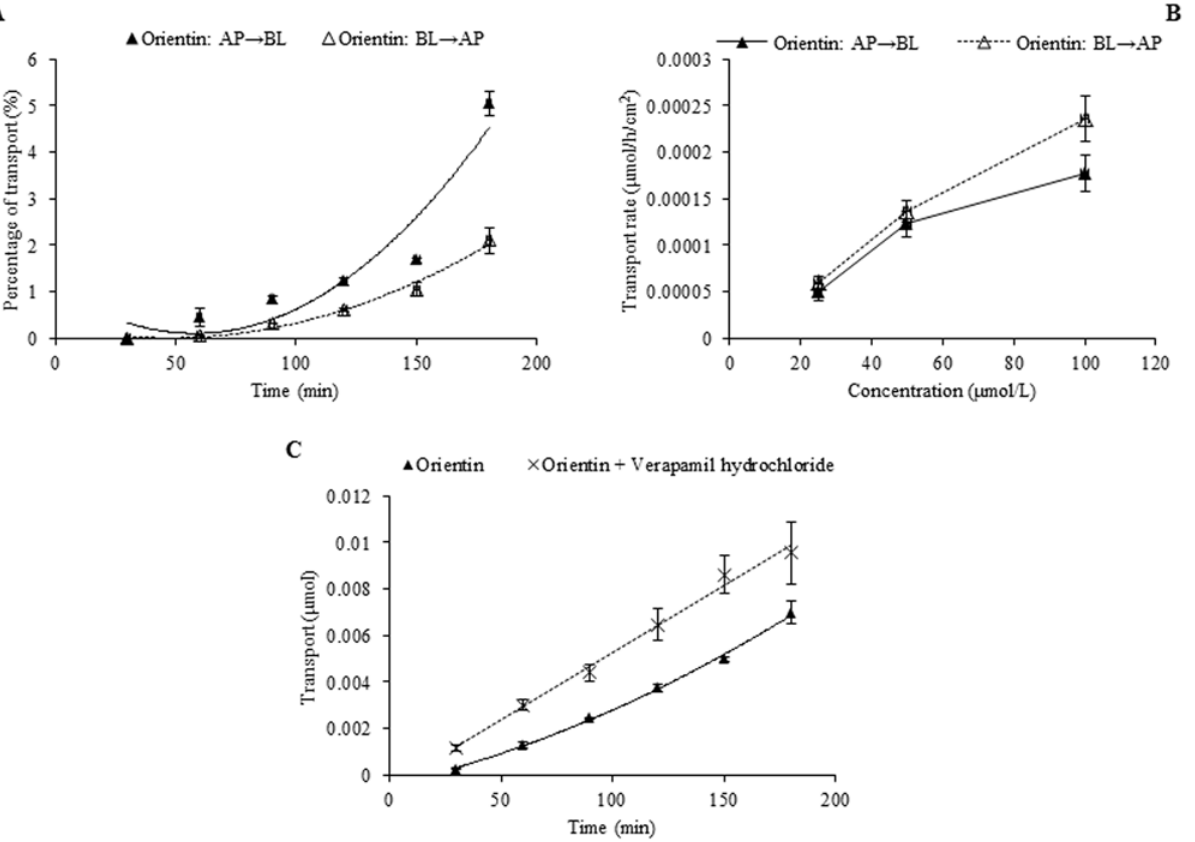
Fig 8. Transport of orientin across Caco-2 cell monolayer. Notes: (A) The percent transport of orientin as a function of time at 50 μ mol/L; (B) The transport rate of orientin as a function of concentration at 90 min; (C) The effect of verapamil hydrochloride on the transport of orientin as a function of time at 50 μ